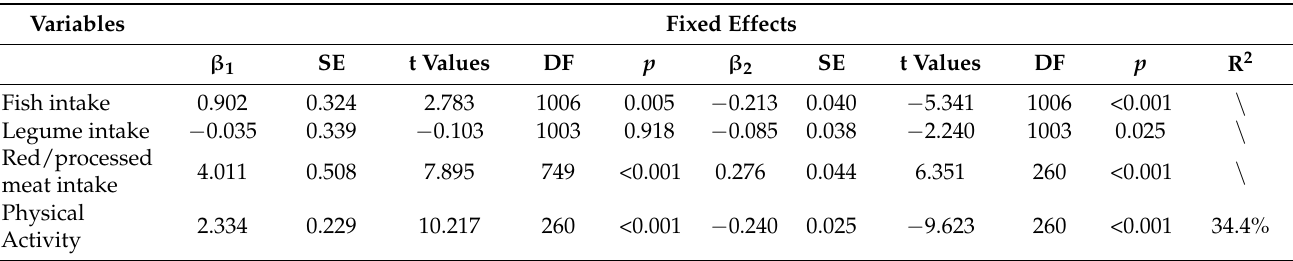
Table 5. Fixed effects for the longitudinal changes in behavioral outcomes (fish intake, legume intake, red/processed meat intake, physical activity).